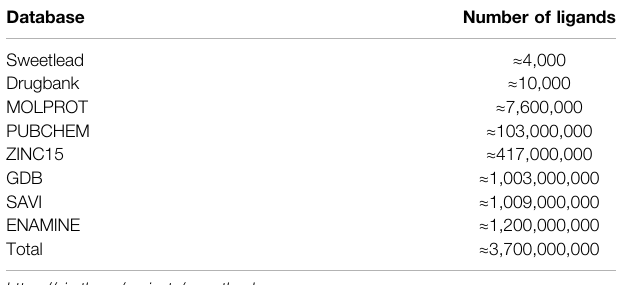
TABLE 2 | The small molecule databases searched as part of the VS